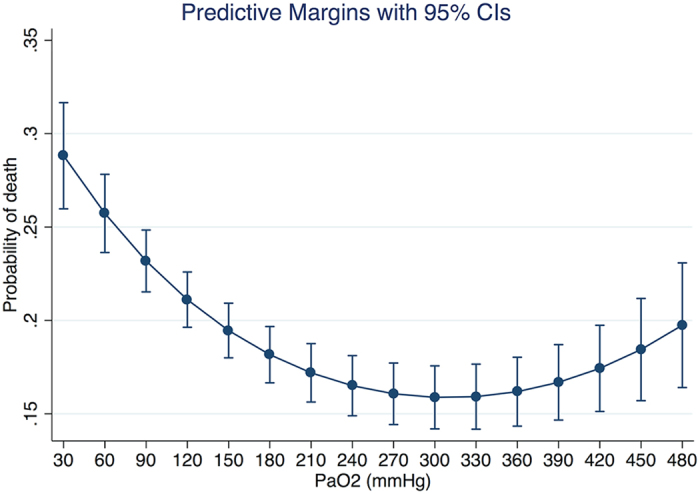
Marginal effect of PaO2 on mortality risk after adjustment for other covariates (all variables finally remained in the model). The probability of death decreases with increasing PaO2, and reaches a nadir at a PaO2 value of 300 mmHg. Thereafter, the probability of death rises with increasing PaO2.